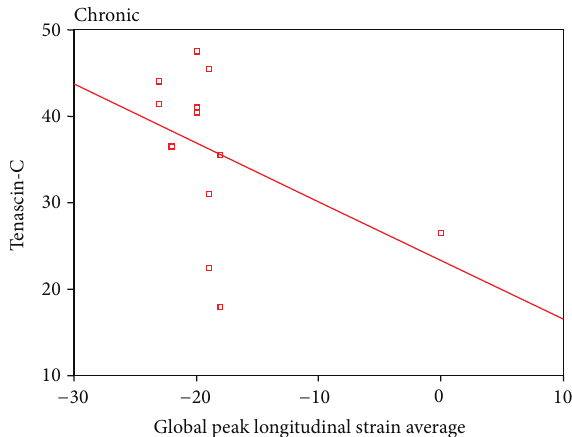
Figure 5: An insignificant negative correlation between serum TN- C and global peak longitudinal strain average in group